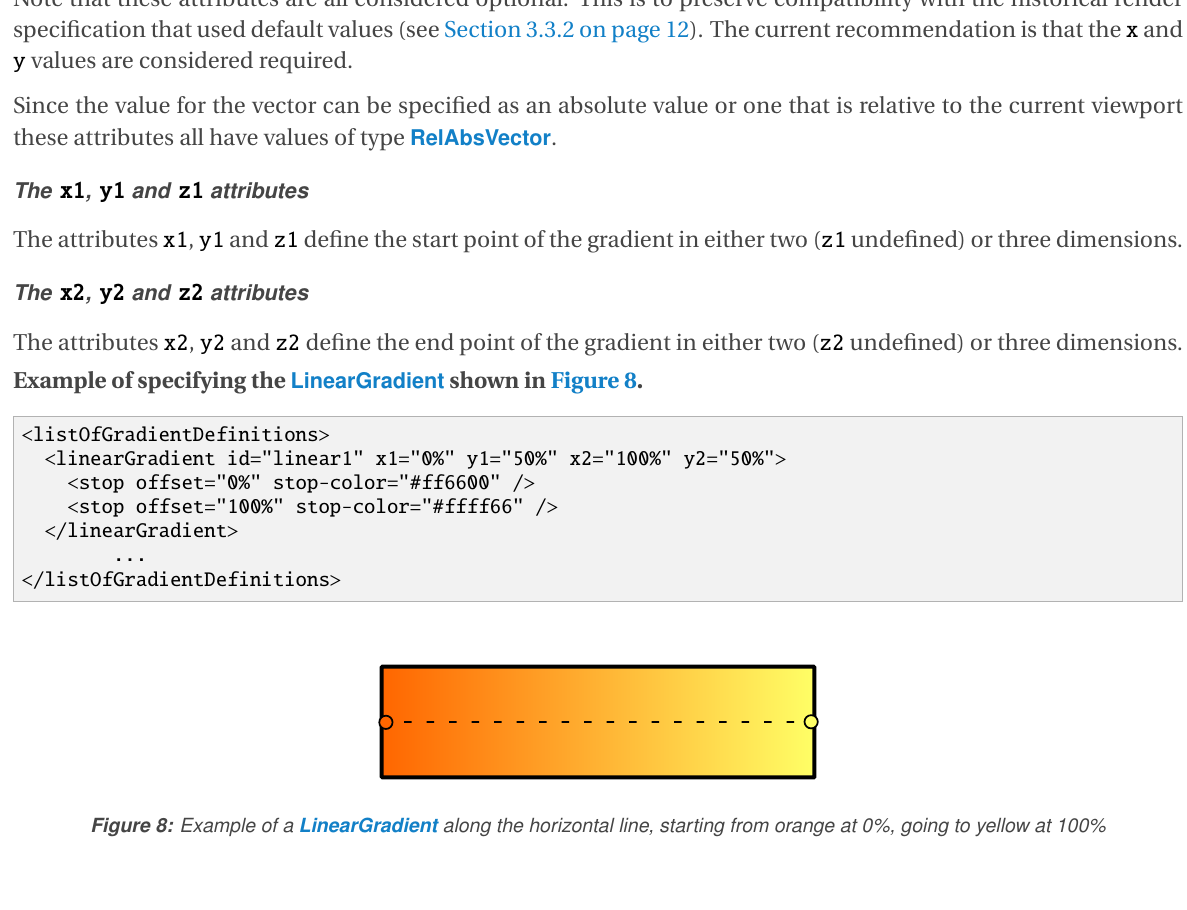
Section 3 Package syntax and